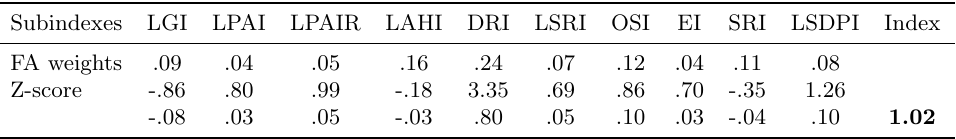
Table 2: An example of the index